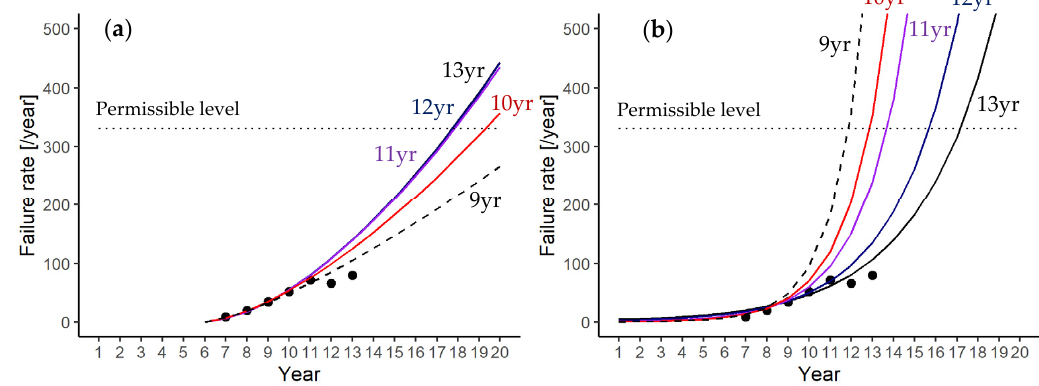
Figure 2. Membrane failure rates in the plant estimated by the power law model ( a ) and by the log-linear model ( b ). Dotted horizontal lines show the permissible failure rates: 330 (black) fibers per year.